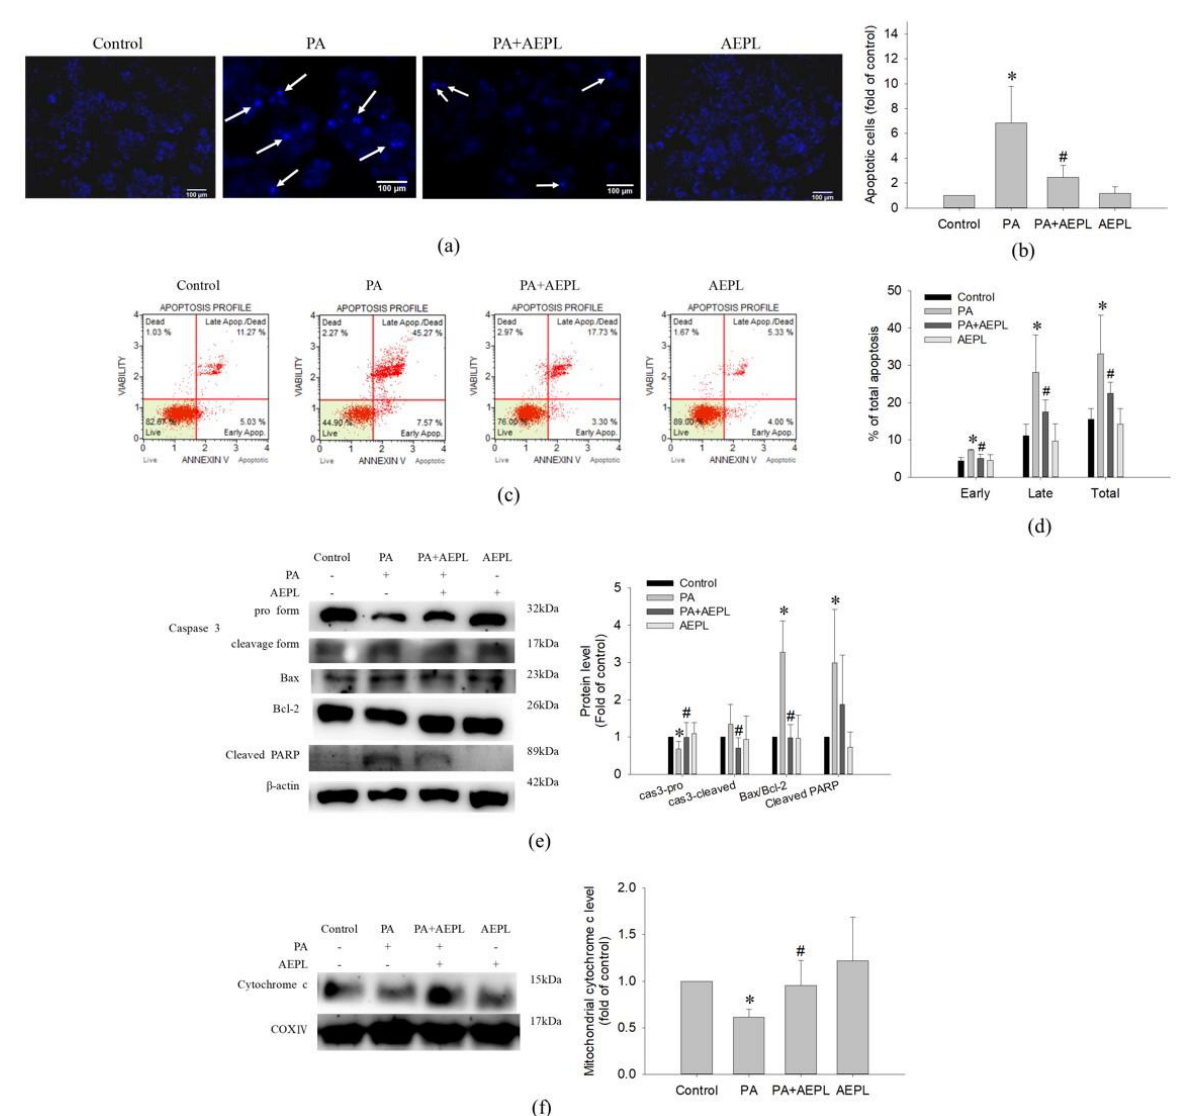
Figure 4. The effect of AEPL on apoptosis. HepG2 cells were treated with PA with/without AEPL for 24 h. ( a ) The morphology change of the nucleus was assessed by DAPI staining. The arrow indicated apoptotic cells. Scale bar, 100 µ m. ( b ) Quantification of apoptotic cells by DAPI staining. ( c ) Annexin V/PI binding assay was performed to evaluate the effect of AEPL on PA-stressed apoptotic cells. ( d ) The percentages of apoptotic cells in early, late, and total apoptotic cells were calculated. ( e ) Apoptosis-related proteins (caspase 3, bcl-2, bax, and cleaved PARP) were analyzed by Western blotting. ( f ) Mitochondrial cytochrome c levels were determined by Western blotting and normalized to that of the COXIV. All data were presented as mean ± SD of three independent experiments. * p < 0.05 vs. control cells; # p < 0.05 vs. PA-treated cells.